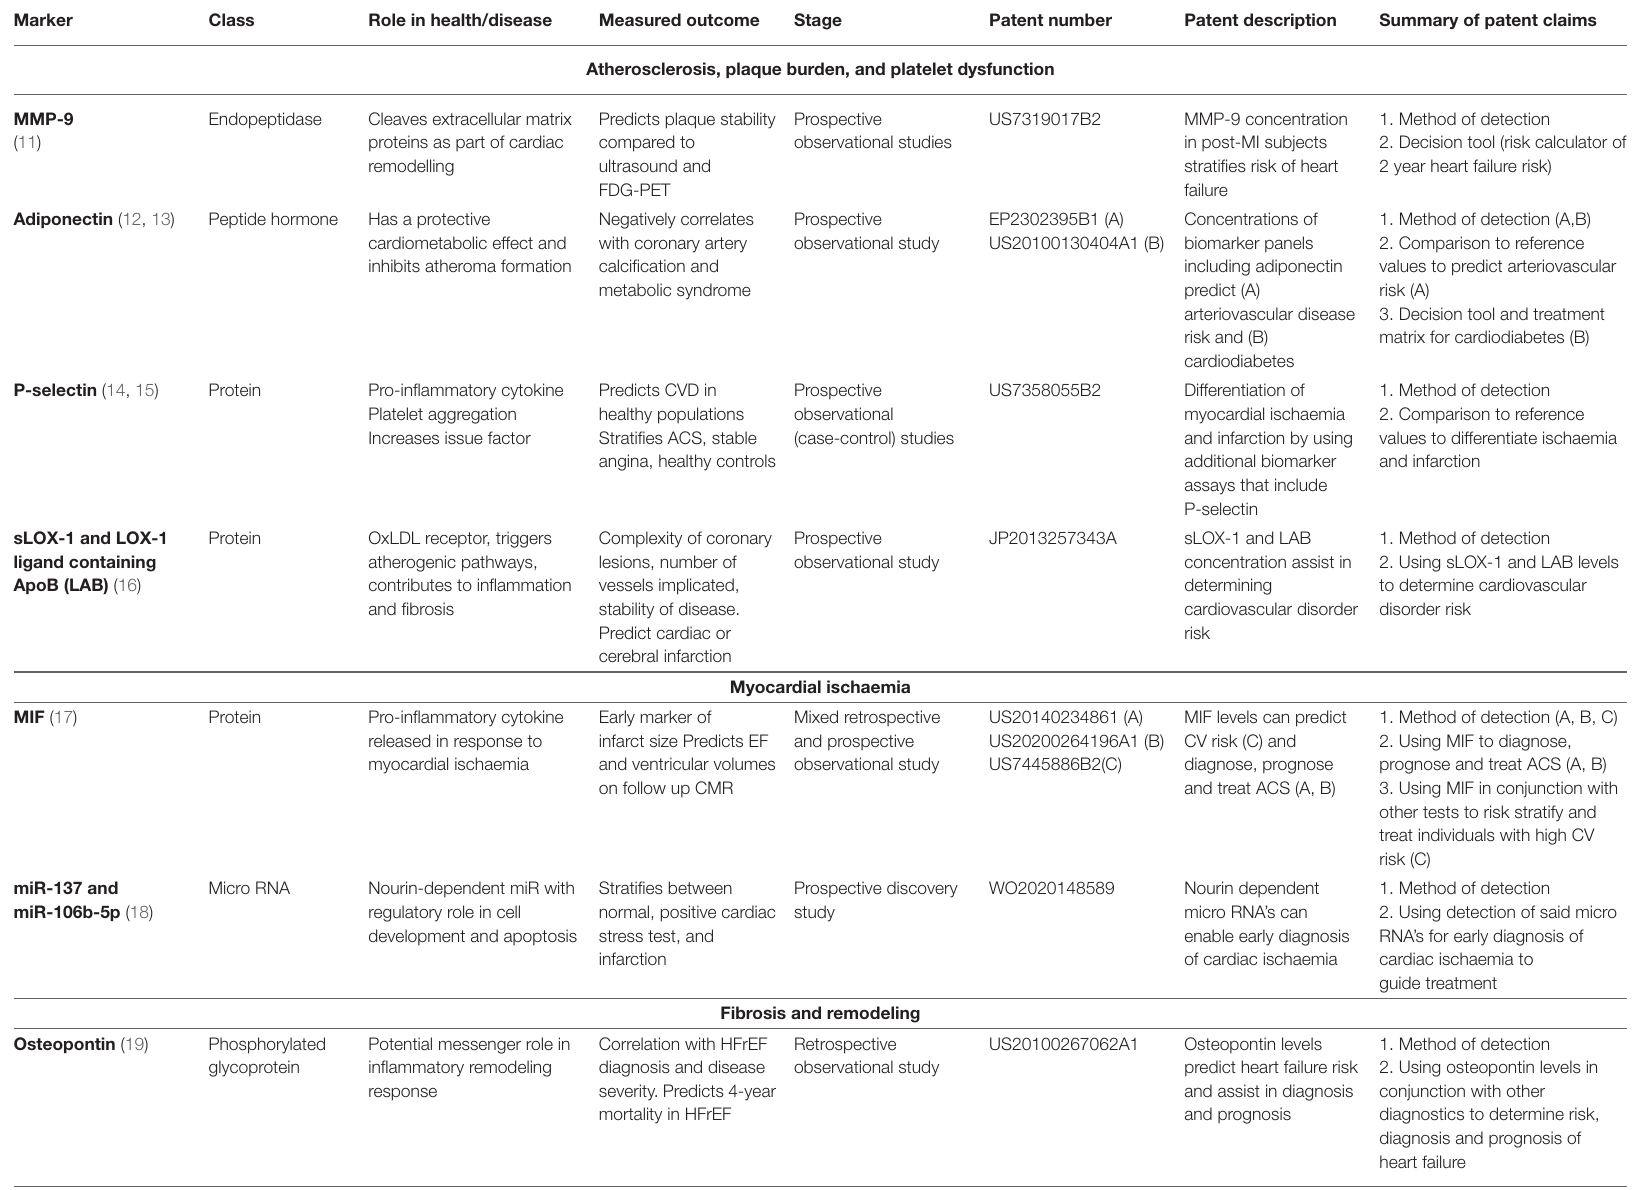
TABLE 1 | Summary of recently patented cardiovascular biomarkers, associated mechanisms and